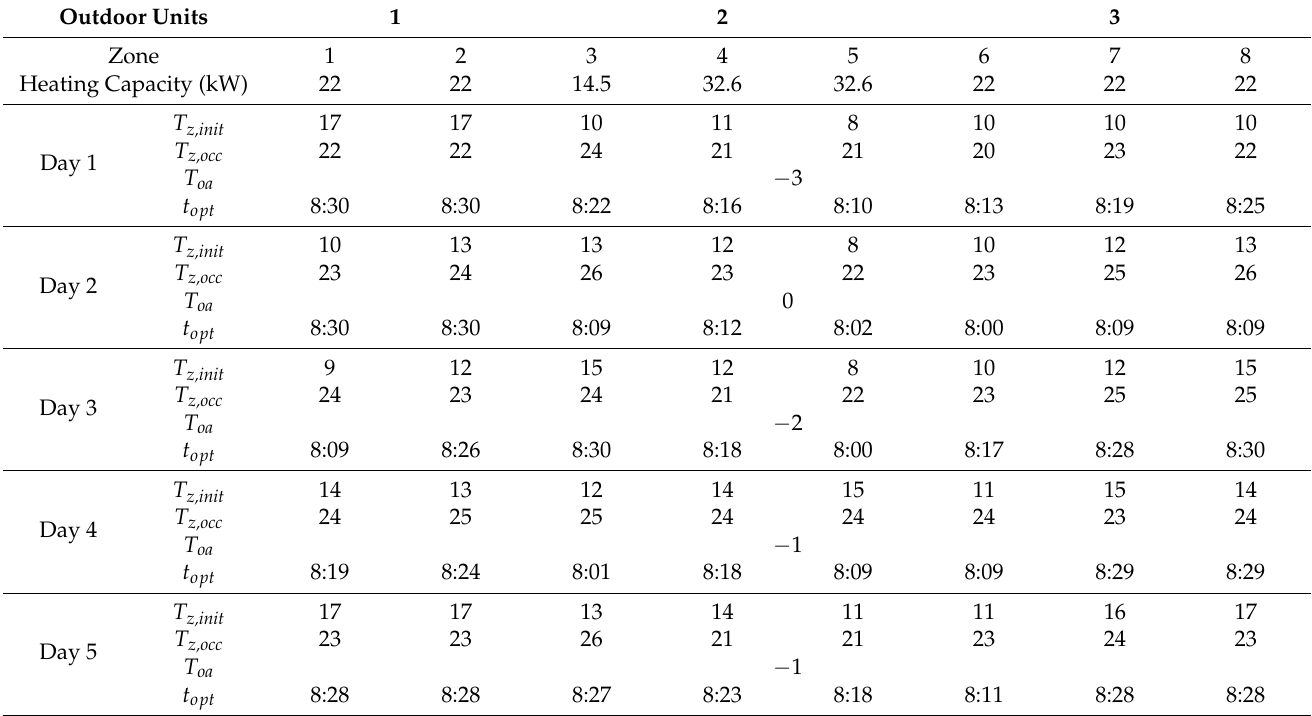
Table 3. Experimental results of optimal start